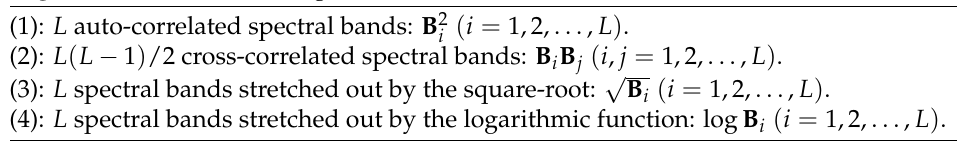
Algorithm 3 Four DE strategies used in GCEM